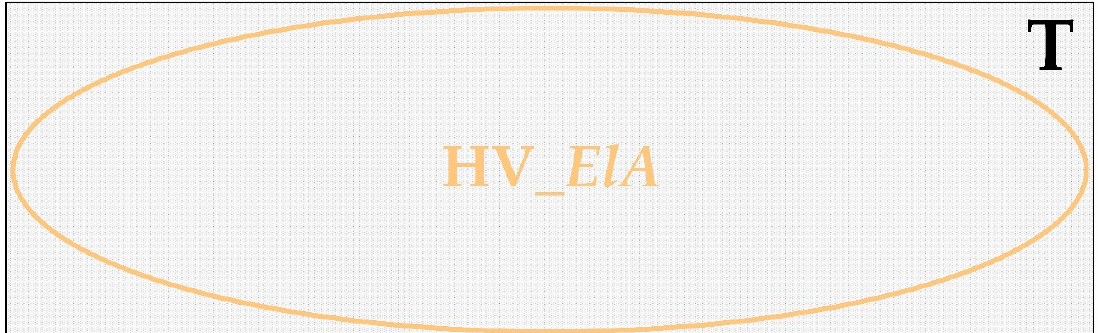
Figure 3. The fractal of high voltage grids (HVGs). Table 2. The fractal structure of smart grids based on di ff erent fractal levels.